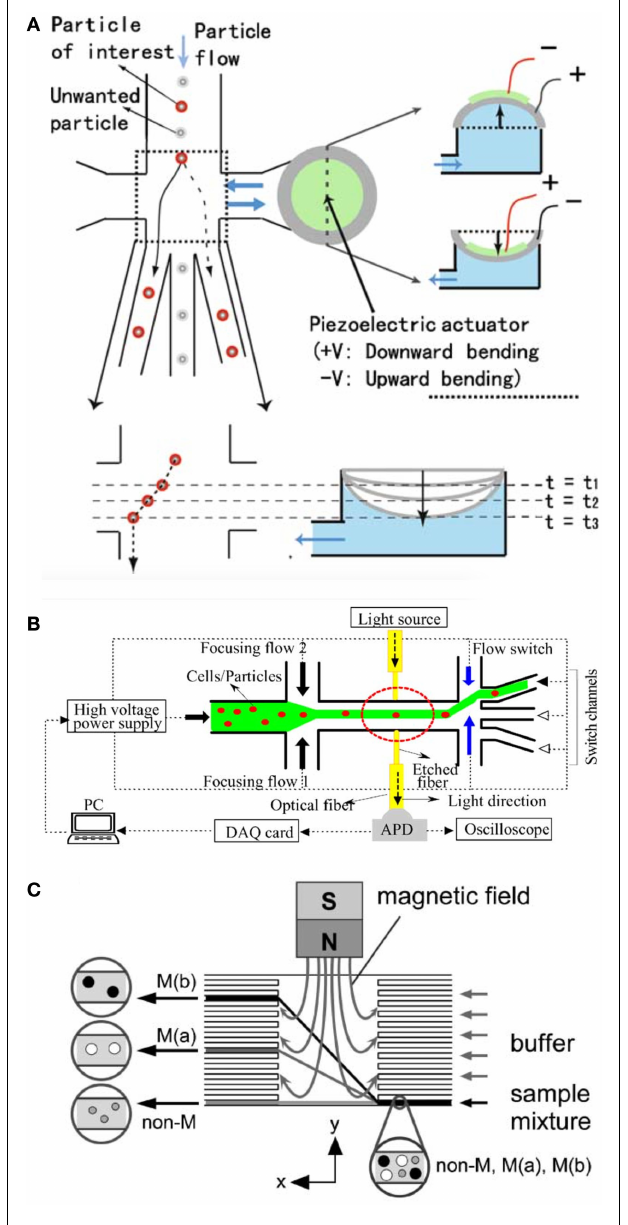
FIGURE 4 | Different flow-cytometry cell sorting systems . (A) (Chen et al., 2009) and (Cho et al., 2010) developed a piezo actuated cell sorting system for cell separation. The flexible piezo actuator acts as a fast pump which pushes or pulls the previously detected cell into different sorting channels enabling the separation of up to 1000cells/s. Reprinted from Chen et al. (2009) with permission of Springer Science + Business Media and Cho et al., 2010 reproduced by permission of The Royal Society of Chemistry. (B) The micro flow cytometer developed by (Fu et al., 2004) employs electrokinetic forces rather than the more conventional hydrodynamic forces technique for flow focusing and sample switching, and incorporates buried optical fibers for the on-line detection of cells or particles. Reproduced by permission of by Elsevier. (C) The group of Pamme and Wilhelm (2006) employed the approach of magnetic cell separation, which is one of the most efficient methods for bulk cell separation. The on-chip free-flow magnetophoresis magnetically labeled cells can be separated into subpopulations of different magnetization with high precision. Reproduced from Pamme et al. (2006a) by permission of The Royal Society of